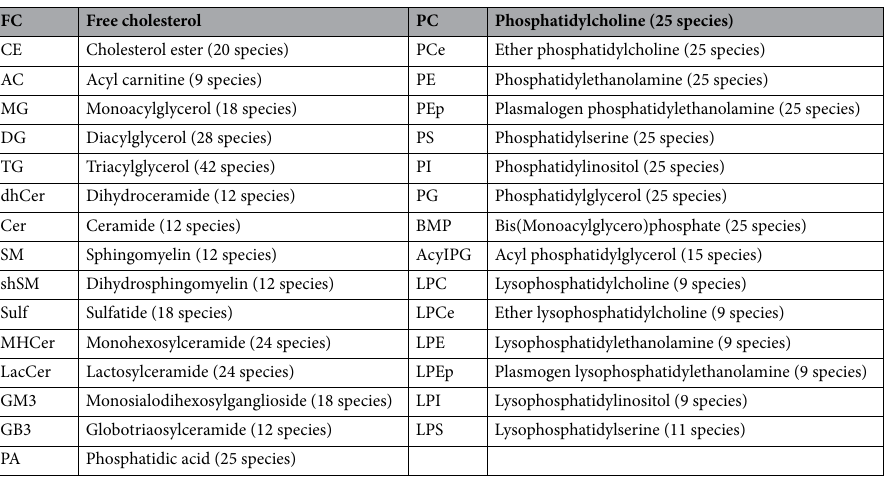
Table 2. Lipid names abbreviations. List of all lipid classes analyzed. The number of species analyzed per class is indicated in